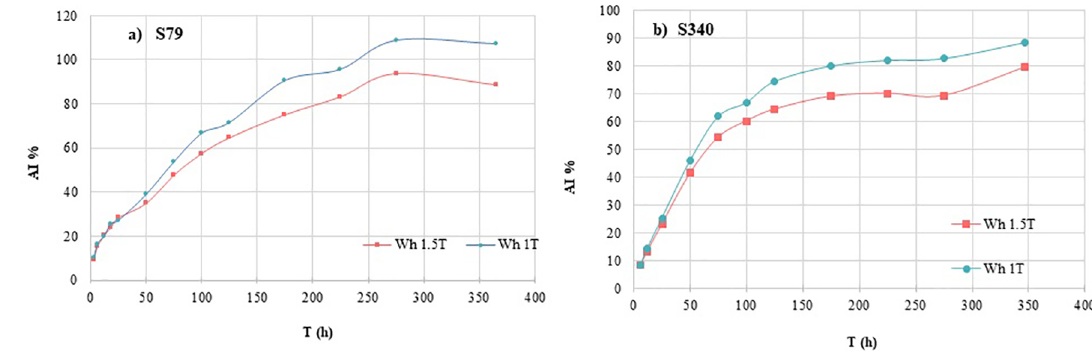
Figure 4. Aging index of hysteresis loss.